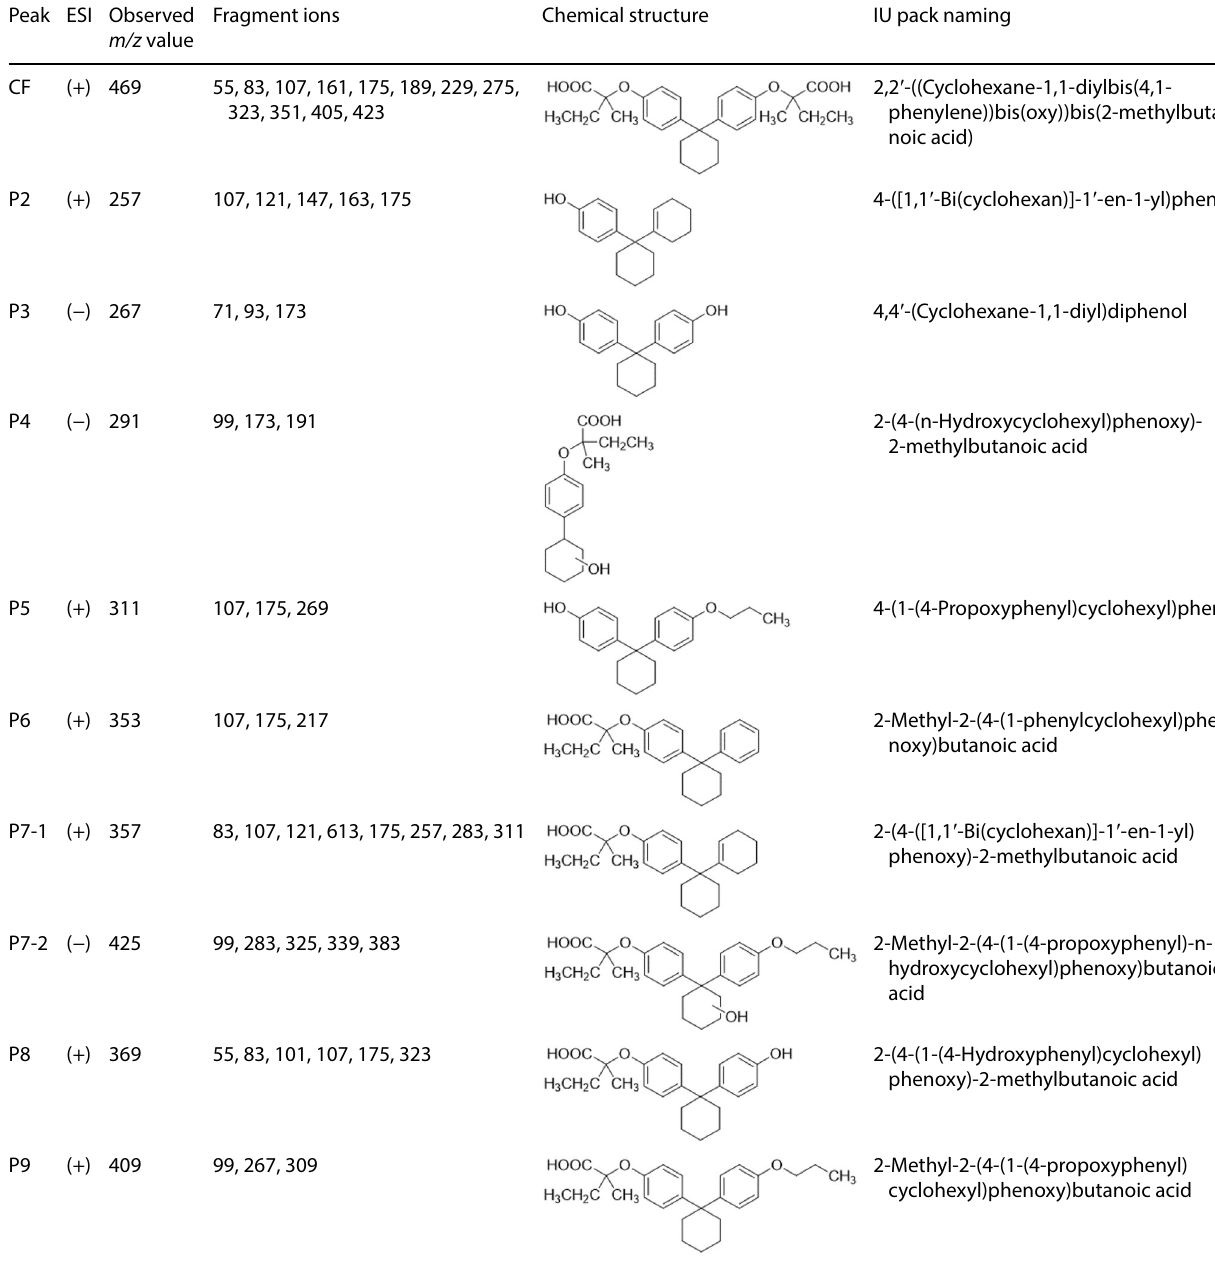
Table 1 Observed m/z values for the detected ions, major fragments and chemical structures of CF and its photoproducts Peak ESI Observed Fragment m/z value